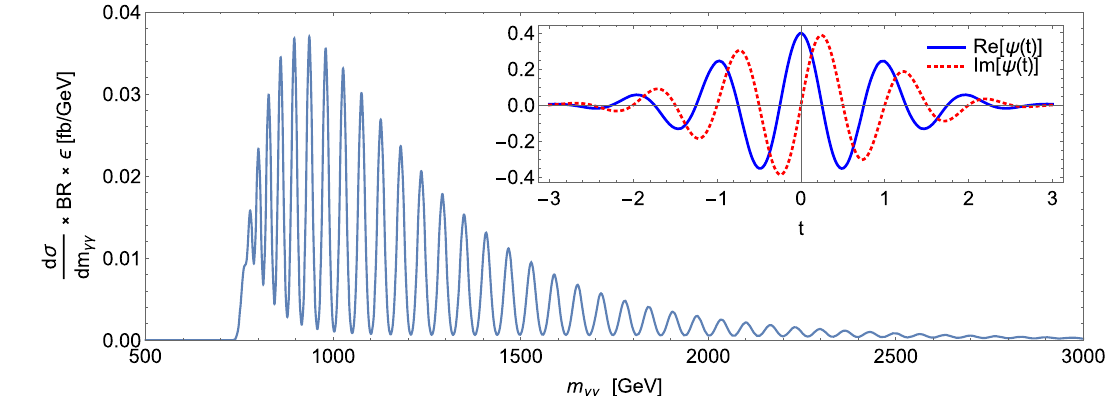
Fig. 1 Example of a periodic signal in the diphoton spectrum from the clockwork/linear dilaton scenario. The parameters are set to k = 750 GeV and M 5 = 3 TeV. See Appendix A for the technical details of